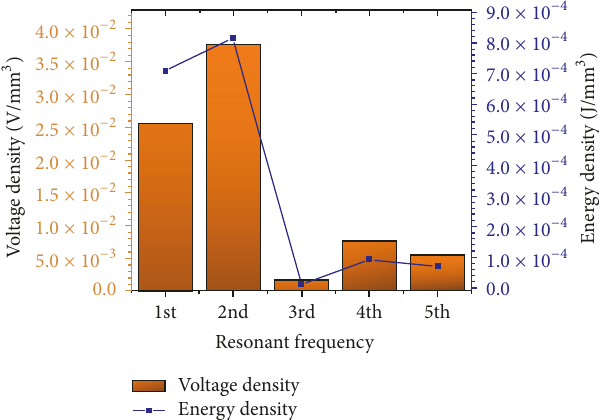
Figure 16: Voltage density and energy density of the harvester at the different resonant